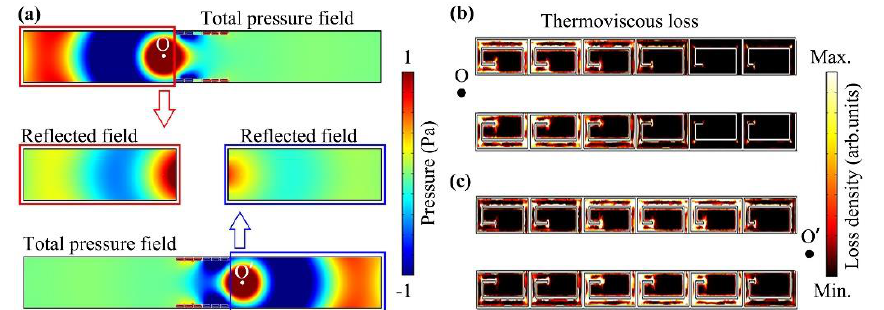
Figure 5. ( a ) We simulated total pressure distributions and corresponding reflected pressure distri- butions through the low-frequency BSI tunnel by separately placing a cylindrical sound source at O and O′ at 343 Hz. We also simulated thermoviscous loss density distributions in the unit cells by separately placing a cylindrical sound source at the points ( b ) O and ( c ) O′ at 343 Hz.